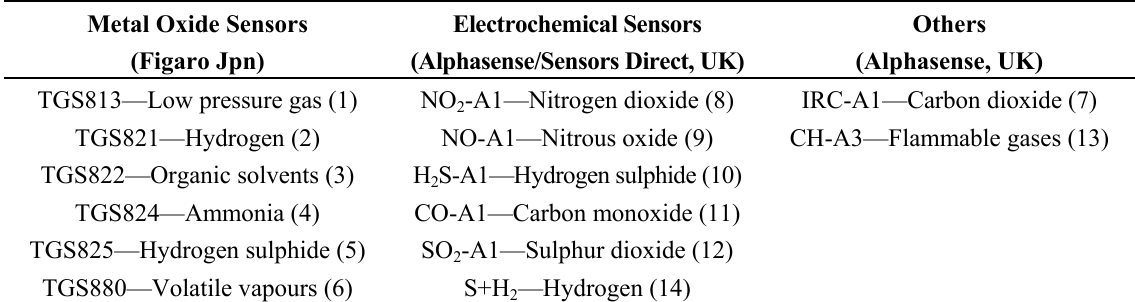
Table 1. Sensors deployed within the electronic nose, with descriptions. Number is brackets is sensor number within the